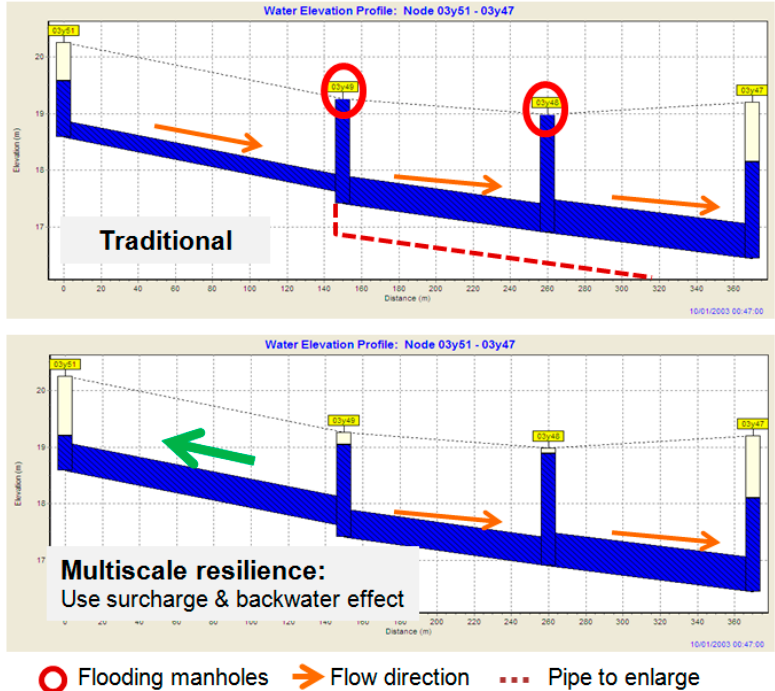
Figure 2. Comparison between traditional and multiscale resilient urban drainage system (UDS0 design concept.